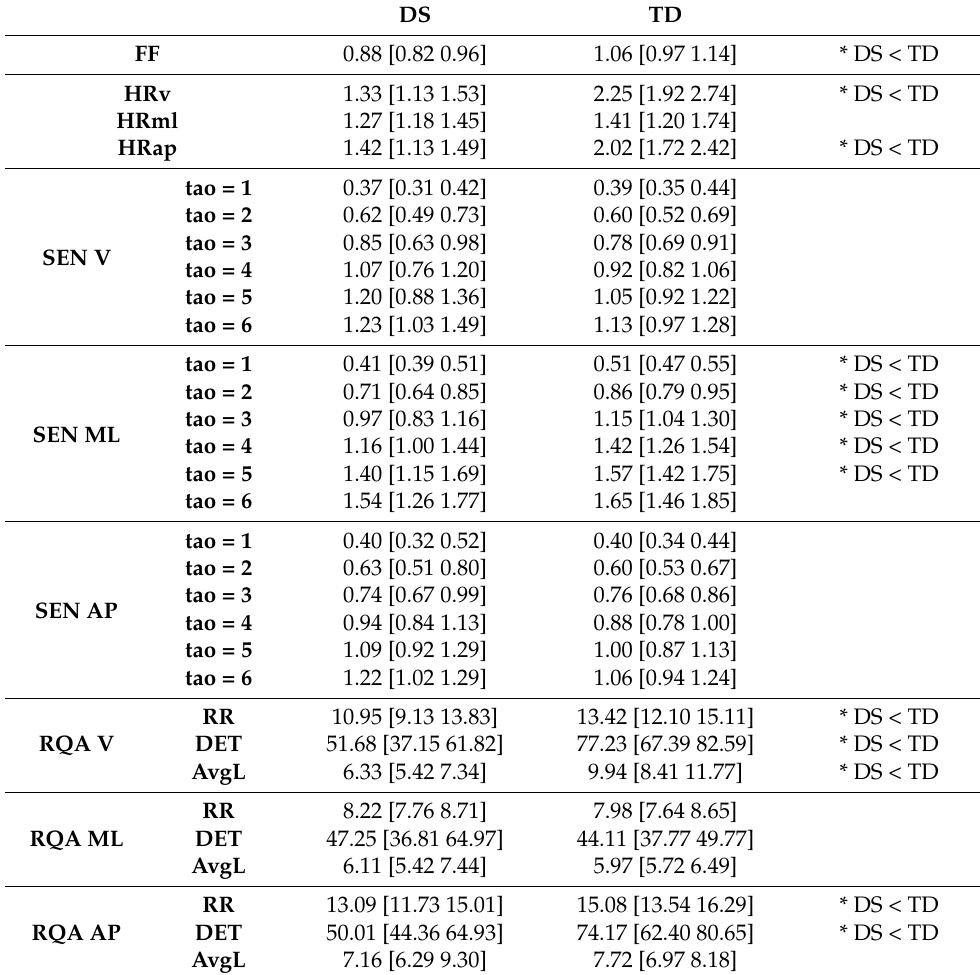
Table 4. Median (25th and 75th percentile) values of estimated nonlinear parameters for DS and TD. Asterisks indicate significant